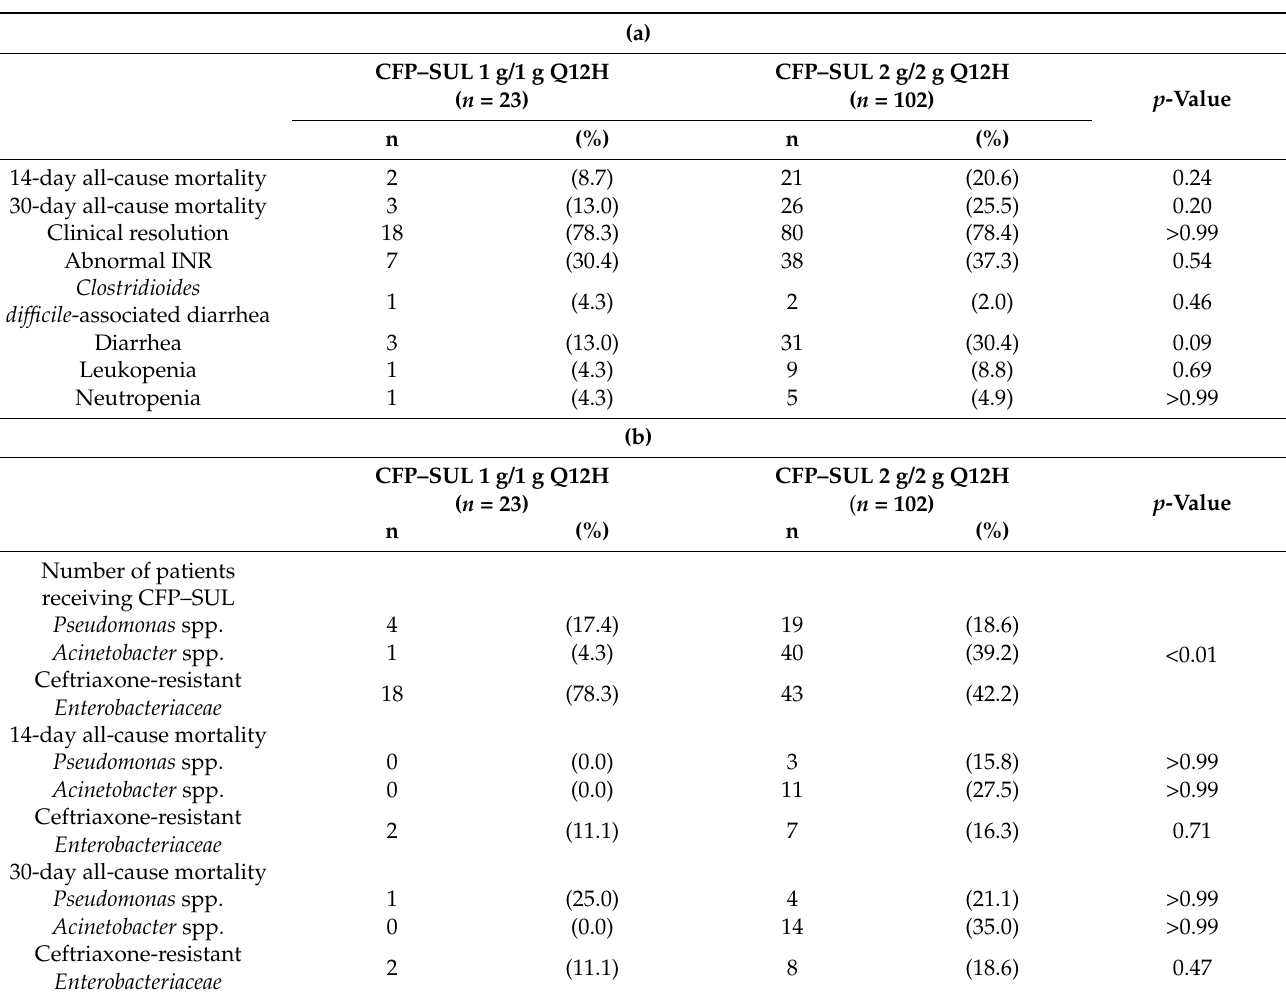
Table 3. (a) Clinical outcomes and adverse effects of patients receiving CFP–SUL for septicemia caused by MDRO, (b) Mortality rate of septicemia caused by MDRO: subgroup analysis.